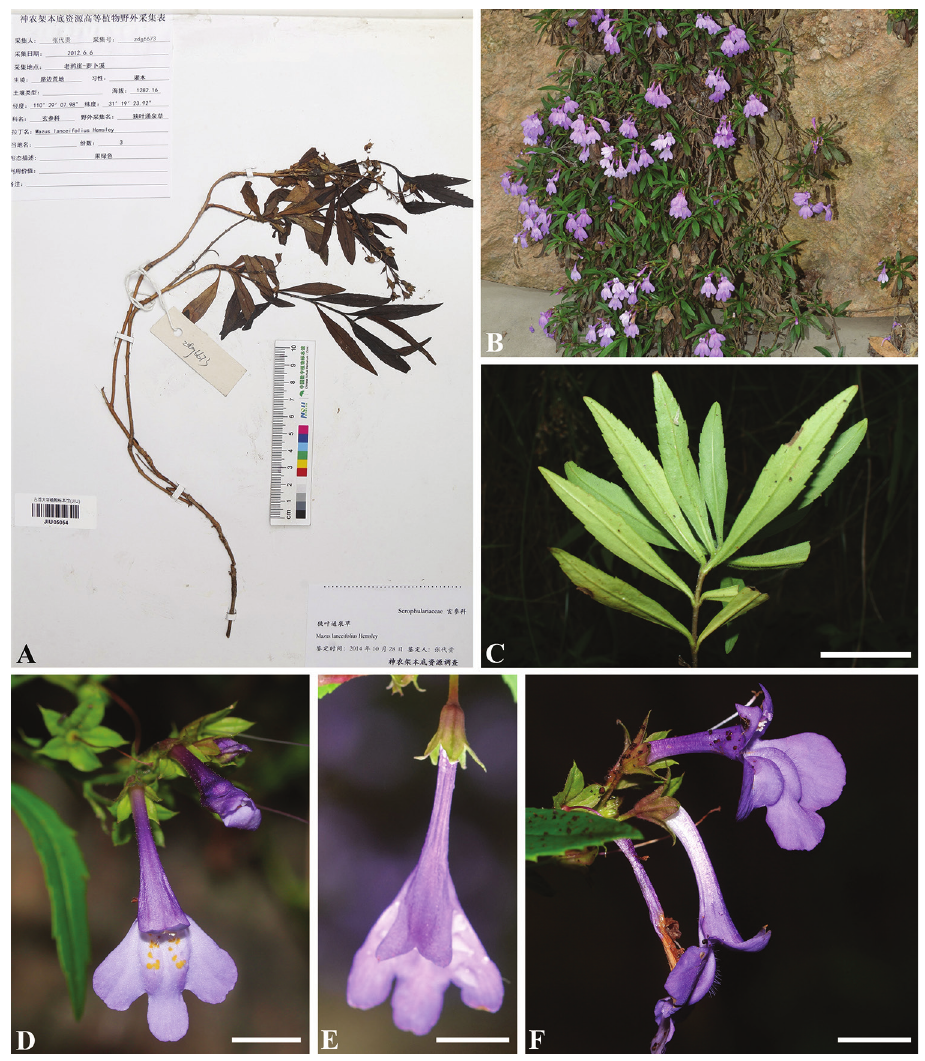
Figure 2. Mazus fruticosus A voucher of “ Mazus lanceifolius ” sampled in Deng et al. (2019), deposited at JIU (the herbarium of Jishou University, Hu’nan, China) B habit and habitat C leaves D flower in frontal view, showing morphology of its lower lips E flower in frontal view, showing morphology of its upper lips F flowers in lateral view. Scale bars: 2 cm ( C ); 0.5 cm ( D, E, F ). Common name (assigned here). Guan Zhuang Tong Quan Cao ( 灌状通泉草 ; Chinese